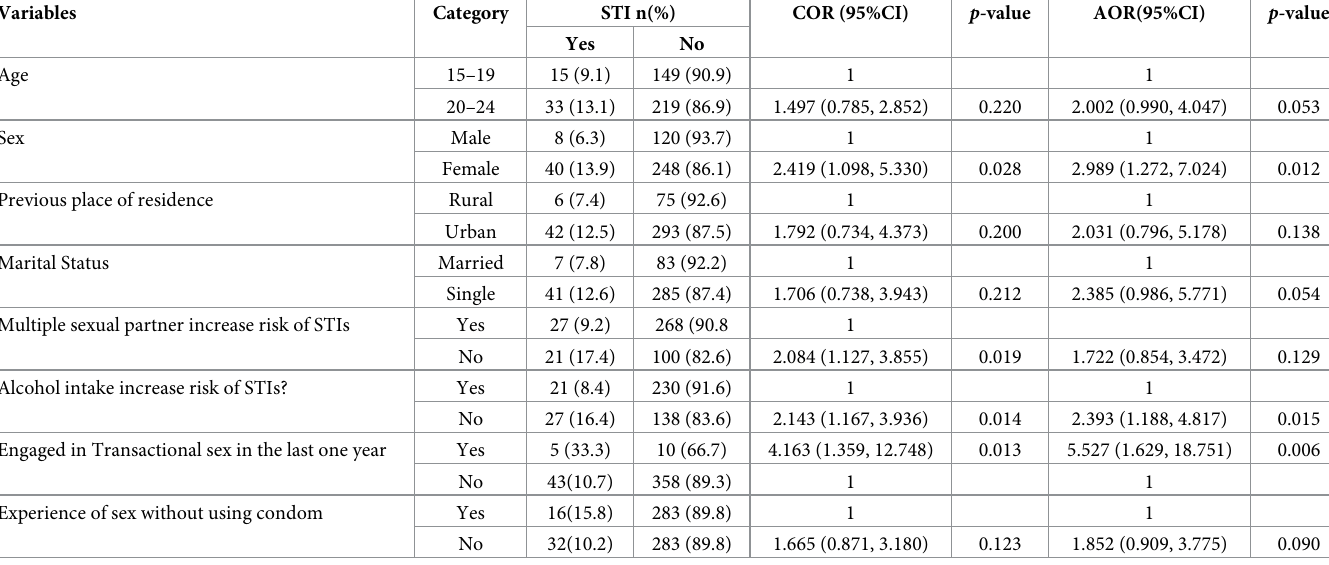
Table 4. Bivariable and multivariable analysis of factors associated with sero-prevalence of sexual transmitted infection among youth-friendly services Attendees at selected health facilities in Hawassa city, Sidama Regional State, Ethiopia, May 1 to August 30, 2021.